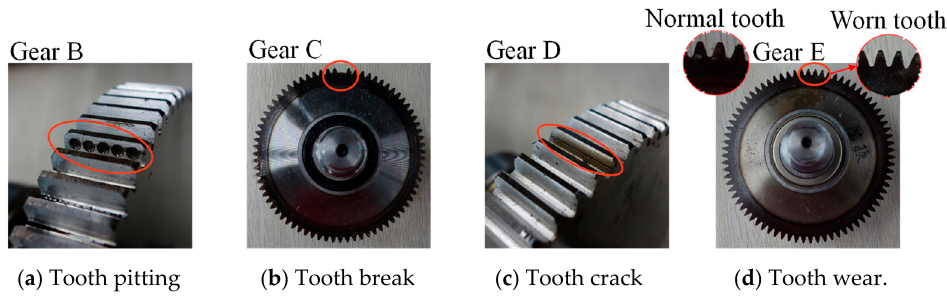
Figure 13. The gears with different fault type.